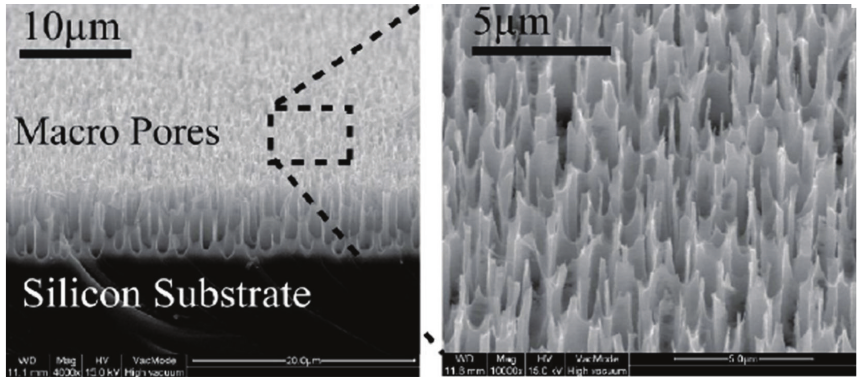
Figure 1: The macroporous surface of modified silicon (adapted from